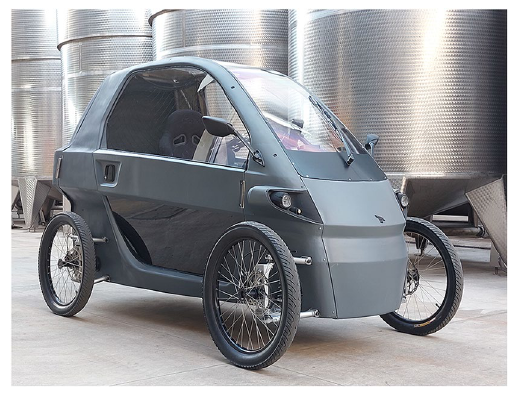
Fig. 1 The electric ultralight quadricycle